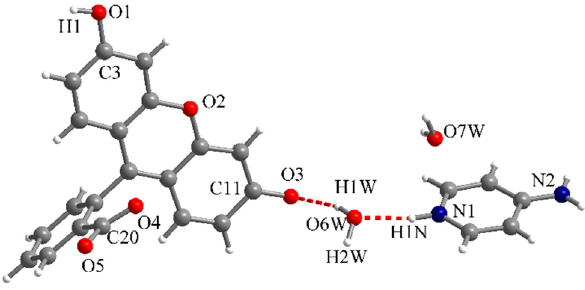
Figure 11. Perspective view of the asymmetric unit in crystal 6 .